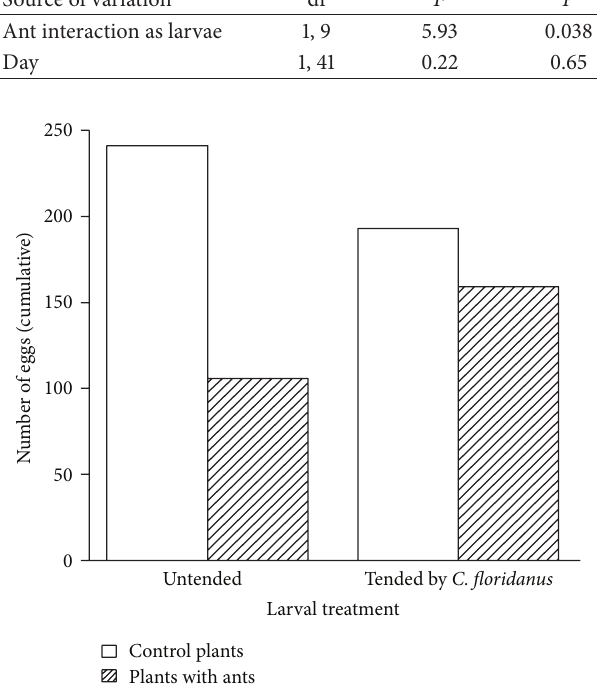
Figure 4: The total number of eggs laid by untended (na¨ıve) females and females tended by C . floridanus as larvae on host plants with ants either present or absent. Although neither category of femalespreferredtoovipositonplantswith C . floridanus present,the oviposition preference of those raised with ants did not differ from random egg distribution whereas the na¨ıve females laid significantly fewer eggs on plants with